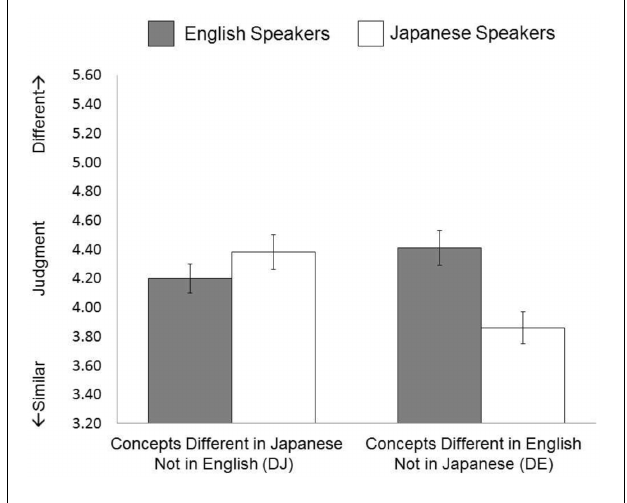
FIGURE 5 | Results of Study